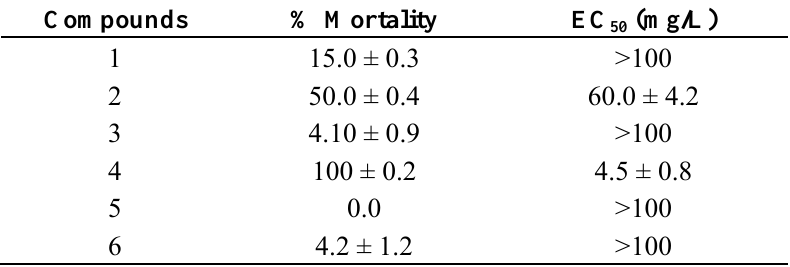
Table 2. Mortality percentage of D. melanogaster larvae , after 168 h of the application of the compounds at different concentrations in larvae’s diet D. melanogaster til-til